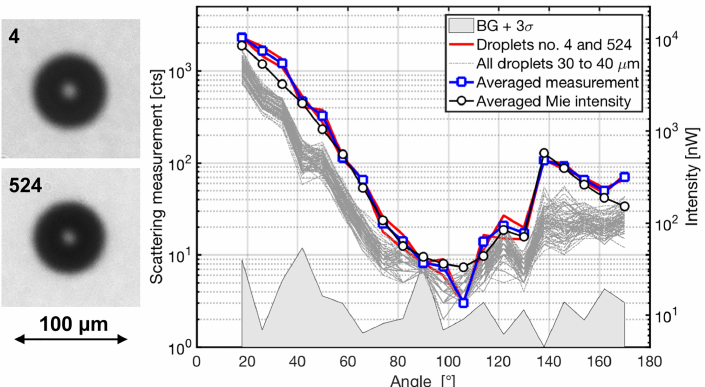
Figure 12. Test of the automatic image-to-scattering function assignment procedure. Sparsely imaged large diameter droplets with similar diameters of 64 and 66µm were selected from the PHIPS-HALO imagery collected in a 12min flight leg in a marine boundary layer cloud. The images (with numbers 4 and 524 in image) were automatically assigned to the particle trigger events no. 738 and 3986 of the angular light scattering data set (red lines). The data set numbers correspond to a time difference of about 10min between the two trigger events. The averaged scattering function of these two events (blue) can be nicely reproduced by Mie calculations for a single droplet with a diameter of 65µm (black). Single particle angular light scattering functions are assigned to those droplets from the imagery that have a diameter between 30 and 40µm (dashed-dotted